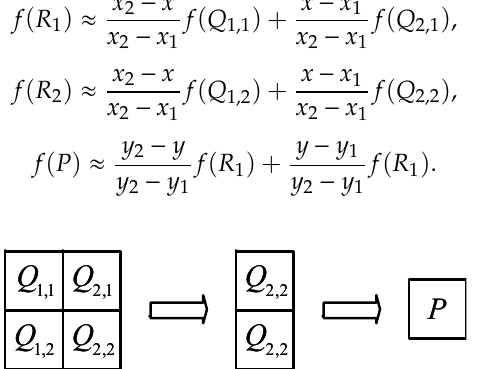
Figure 4. Dimensionality reduction via bilinear interpolation.